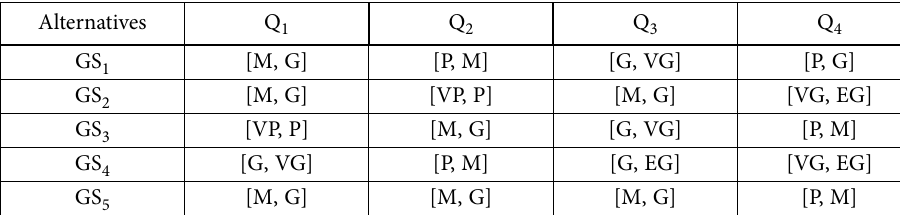
Table 6. The ULTSs through DM 1